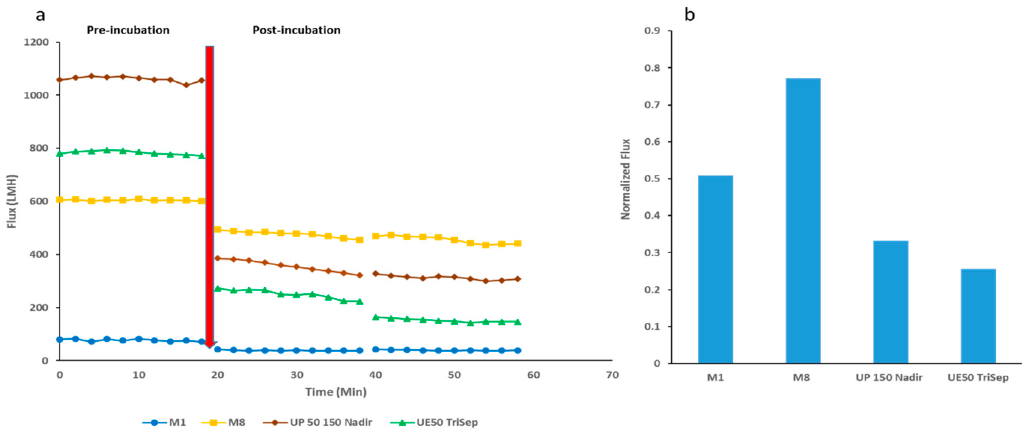
Figure 13. Change in flux over time before and after overnight incubation (denoted as the red arrow) of different PES/GO membranes with E. coli suspension ( a ) and normalized flux data for each membrane ( b ).